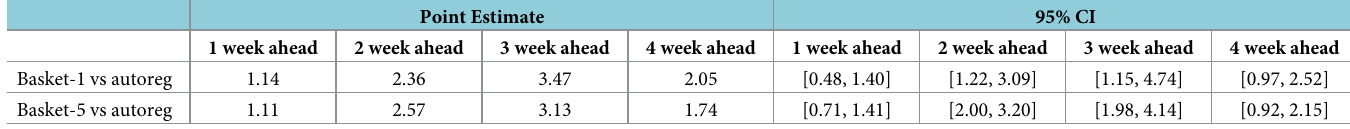
Table 2. Relative efficiency. Estimate of relative efficiency of our approach compared with the autoreg baseline with 95% confidence interval (CI). Relative efficiency being larger than 1 suggests increased predictive power compared with the alternative